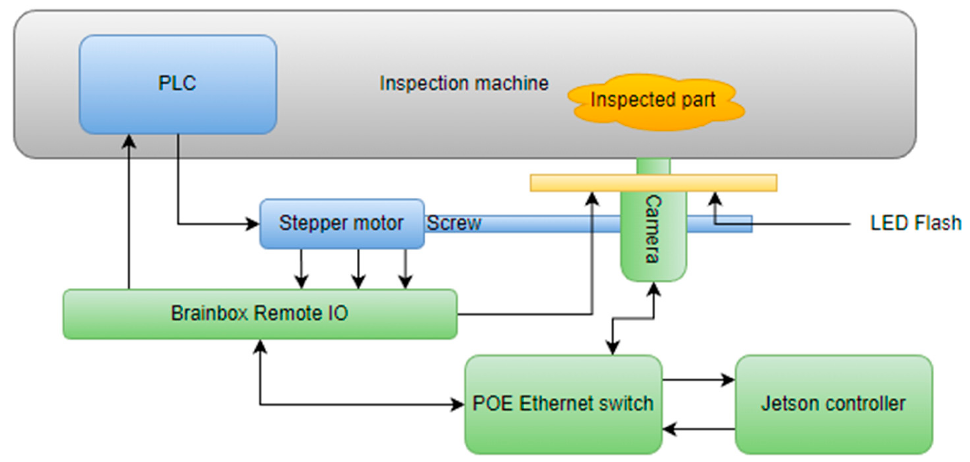
Figure 5. System architecture of the video inspection operation.